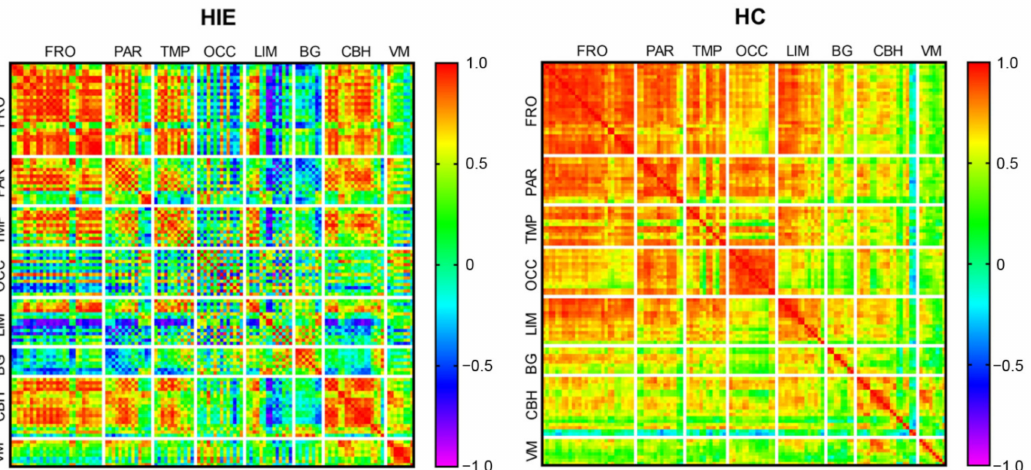
Figure 3. Global metabolic connectivity matrix. Colors in the metabolic connectivity matrix represent the magnitude of the correlation and colors are arranged as a rainbow color from red to purple according to the magnitude of the correlation from positive to negative. HIE, hypoxic ischemic encephalopathy. HC, healthy control. FRO, frontal cortex. PAR, parietal cortex. TMP, temporal cortex. OCC, occipital cortex. LIM, limbic structures. BG, basal ganglia. CBH, cerebellum hemisphere. VM, vermis of